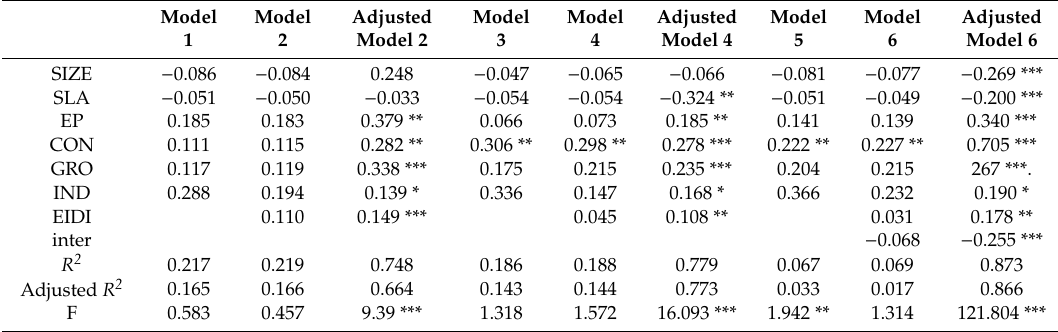
Table 3. Regression